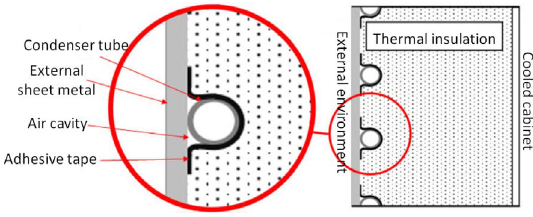
Figure 2. Detail of the skin condenser tube [8].